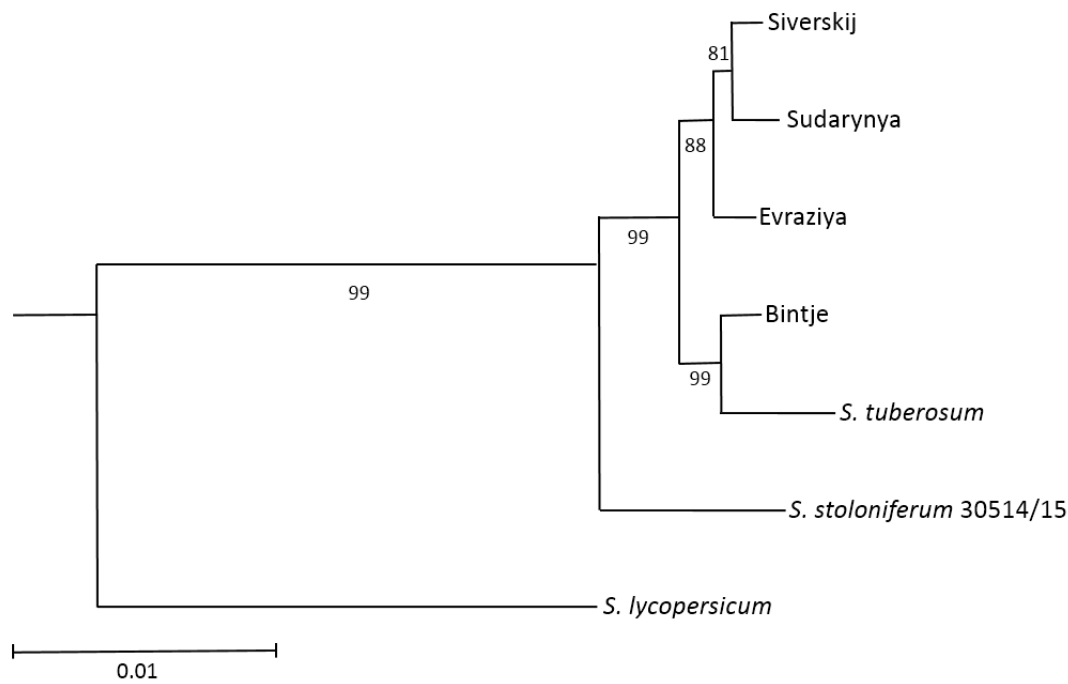
Figure 2. Phylogenetic tree reconstructed by IQ-TREE maximum likelihood method for concatenated sequence alignment of 172 single-copy orthogroups. Tree is rooted at S. lycopersicum node (outgroup). Distance scale shown below the tree.